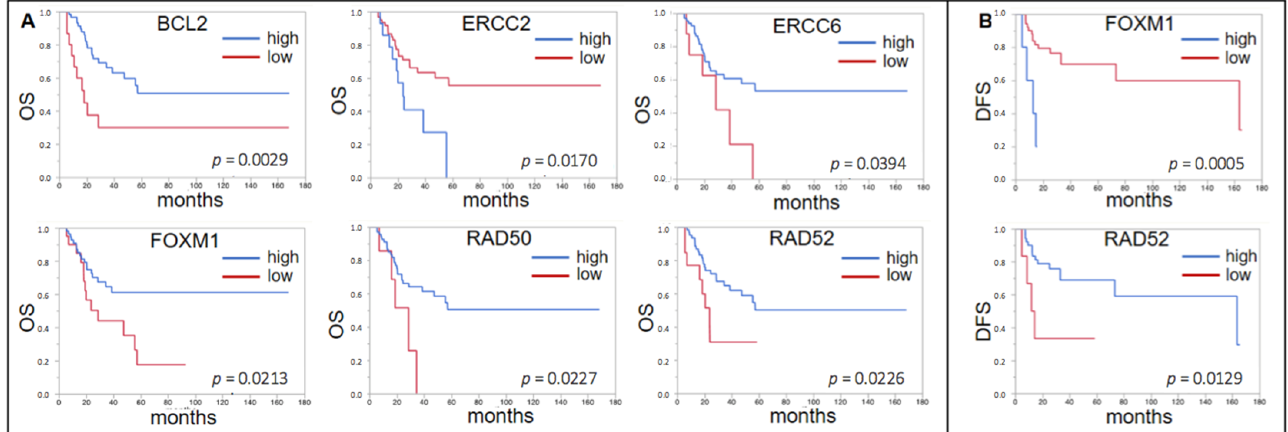
Figure 4. ( A ) Forrest plots of the correlation between RNA expression of DDRG and OS in the TCGA ACBC cohort. ( B ) Forrest plots of the correlation between RNA expression of DDRG and DFS in the TCGA ACBC cohort.